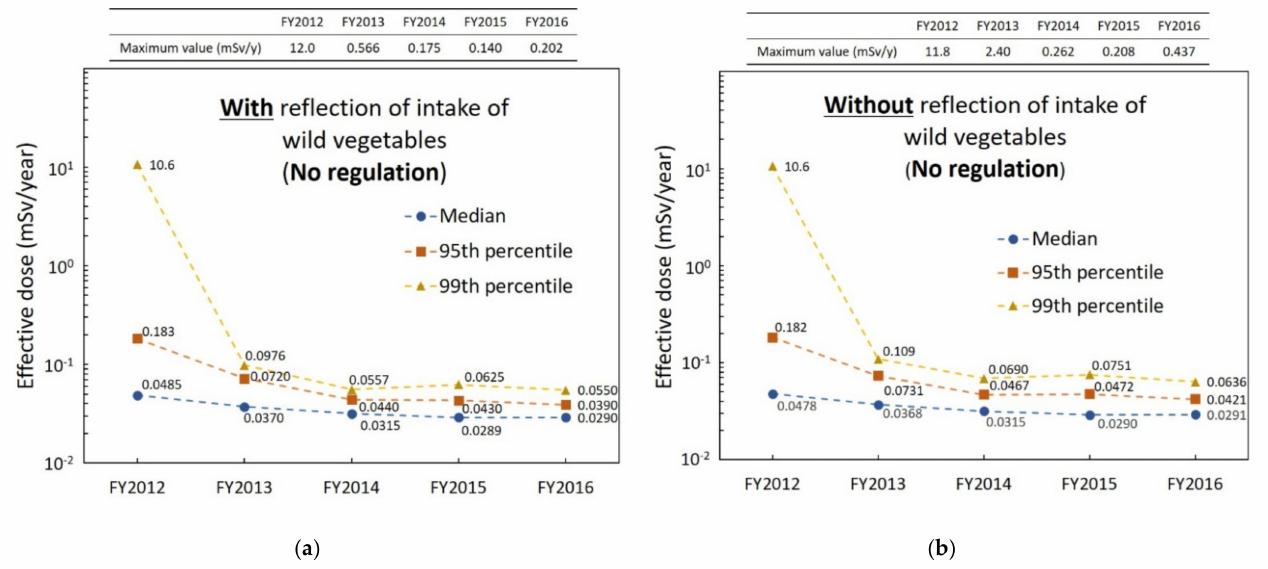
Figure 6. Longitudinal change of internal exposure dose in the case assumed to be “no regulation”: ( a ) with and ( b ) without the reflection of intake of wild